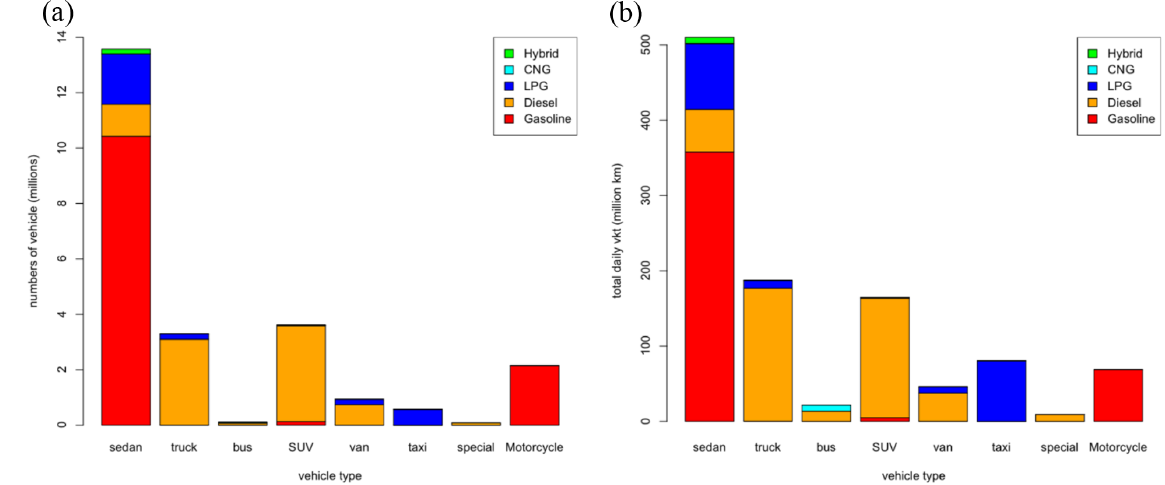
Figure 2. (a) The number of vehicles by vehicle and fuel types and (b) the total daily VKT by vehicle and fuel type in South